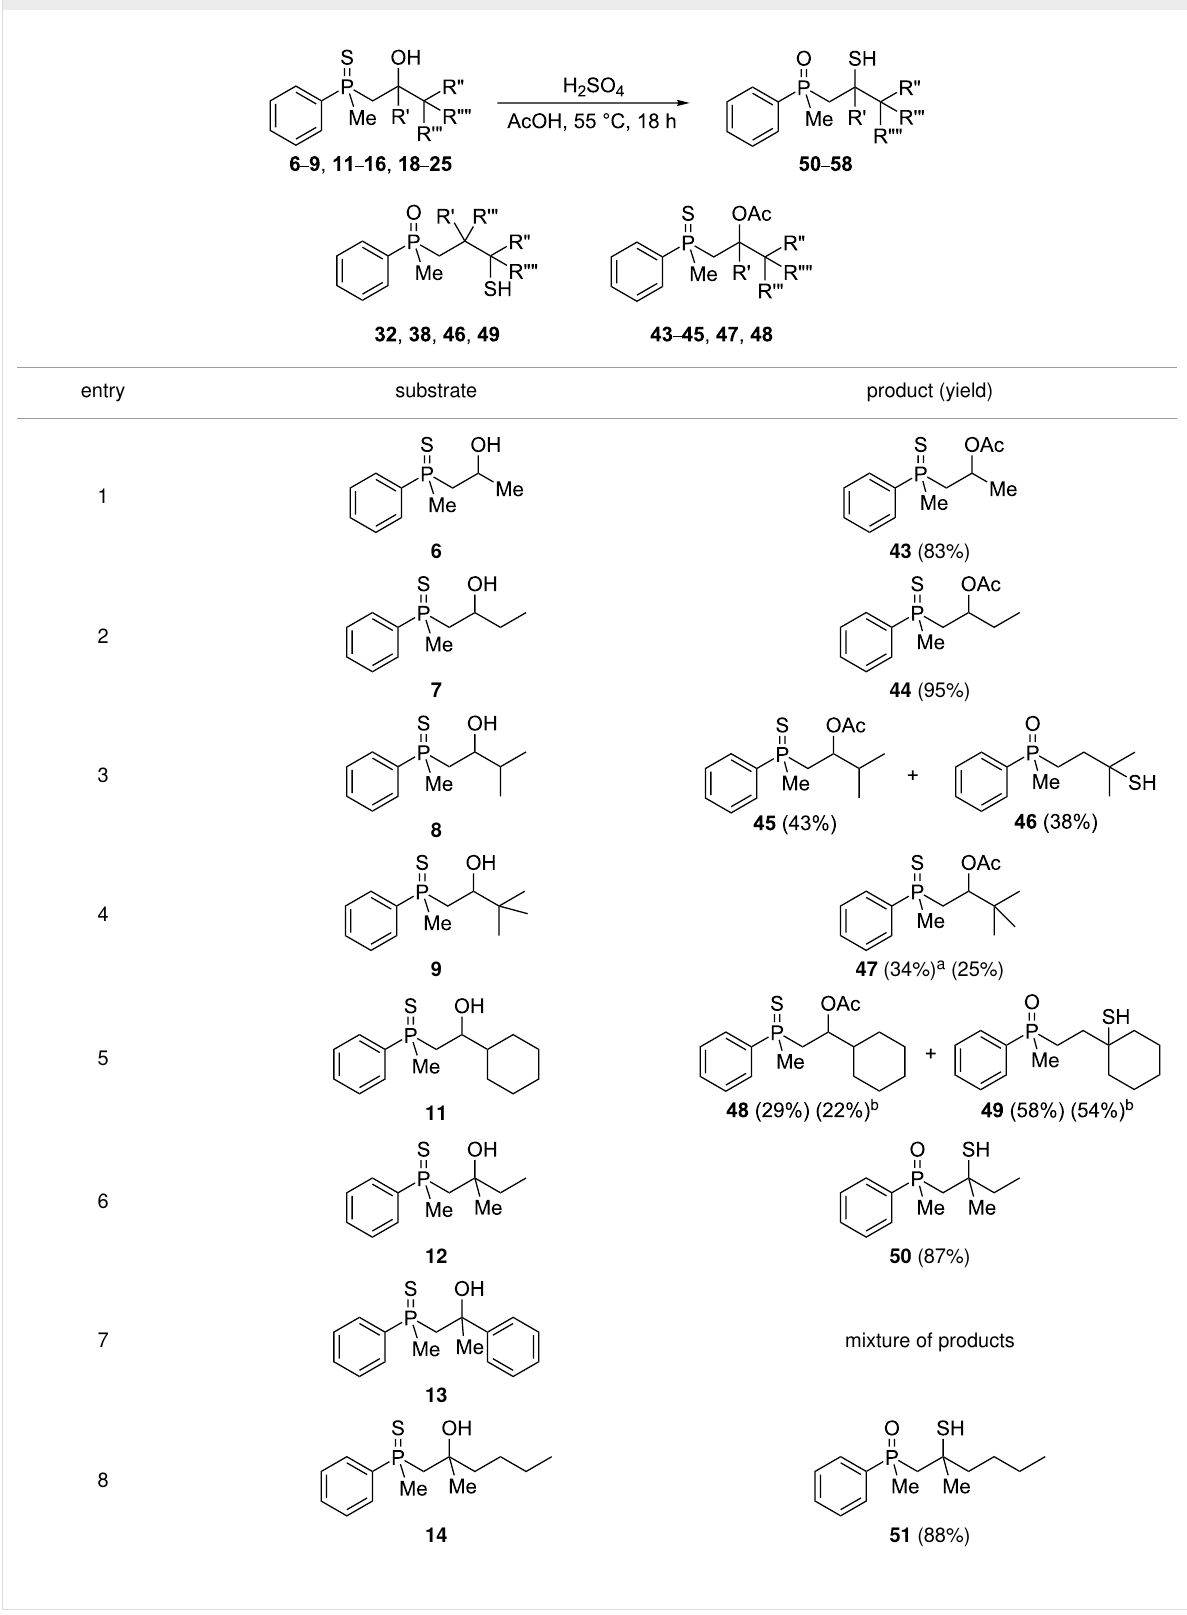
Table 3: Reaction of β -hydroxyalkylphosphine sulfides with Brønsted-acidic H 2 SO 4